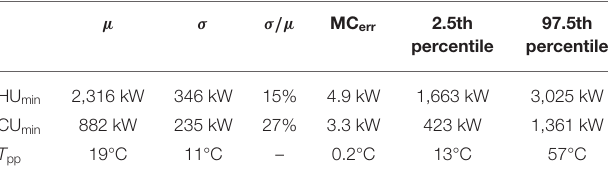
TABLE 3 | Uncertainty analysis results for the reduced input uncertainty on k = 28 parameters ( SRC VDSA { ∩ }